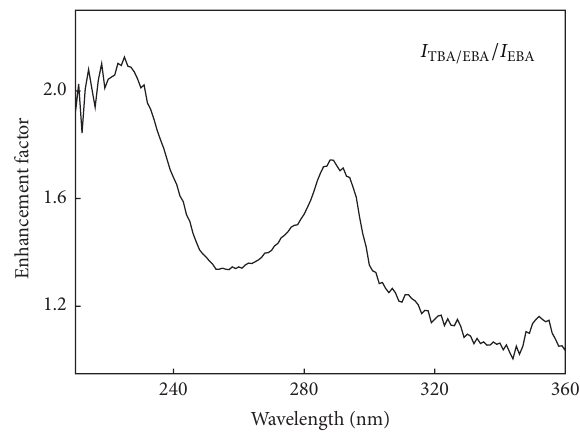
Figure 9: Enhancement factor of 610nm fluorescence between 0.8 wt% TBA-0.2wt% EBA coincorporated and 0.2 wt% EBA incor- porated PMMA.